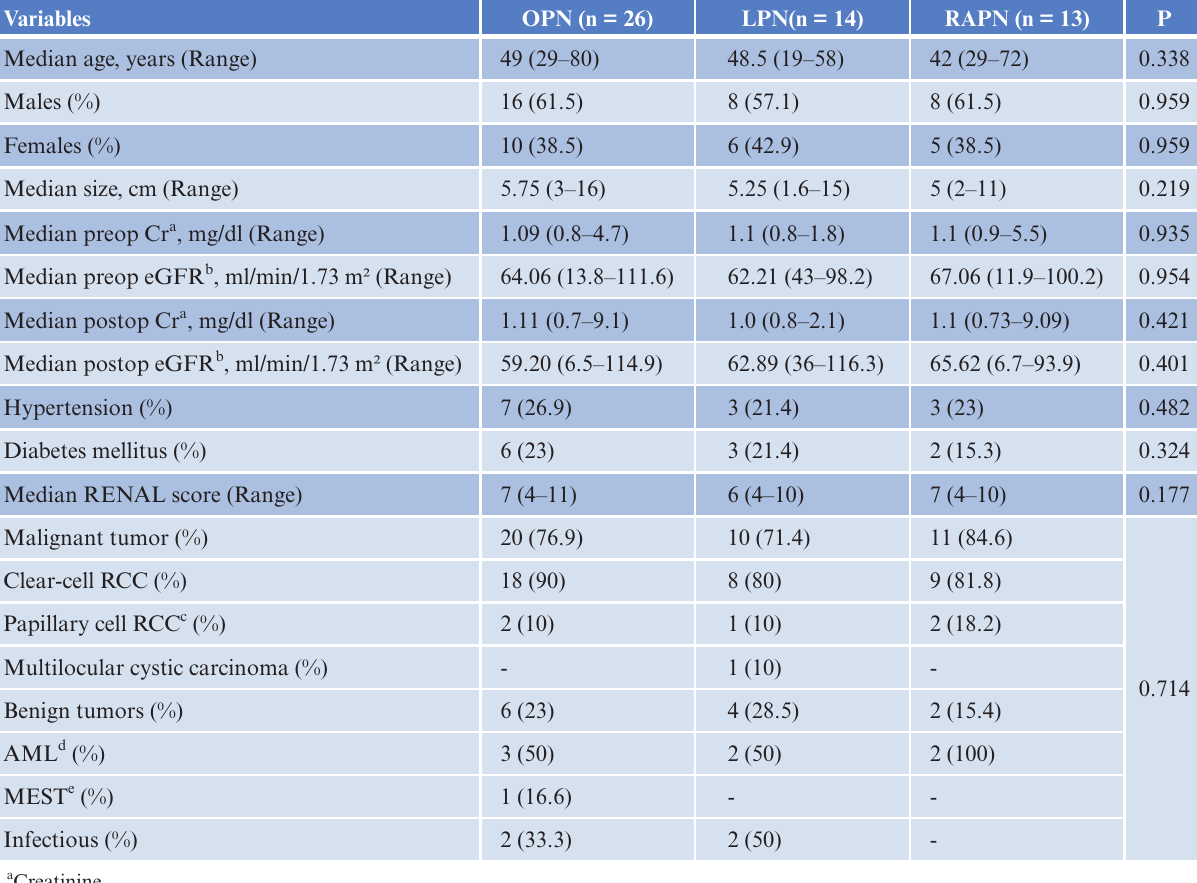
Table 1: Patient and tumor characteristic